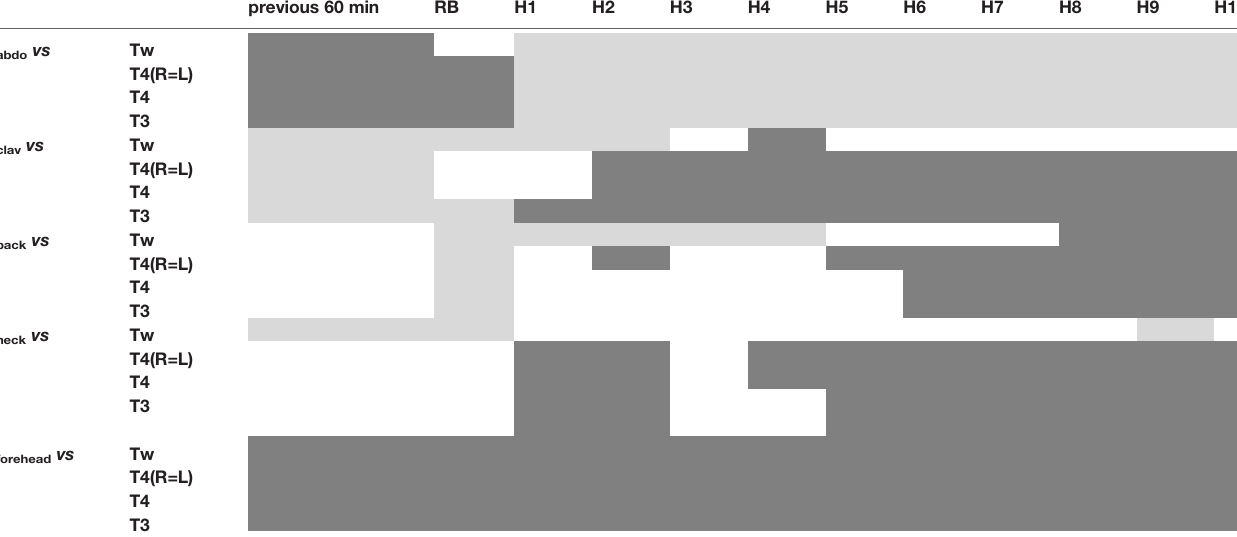
TABLE 3 | Results of the paired comparisons between each of the local proximal Ts (T abdo , T clav , T back , T neck , T forehead ) with each of the average proximal Ts (Tw, T4 (R=L), T4, T3). previous 60